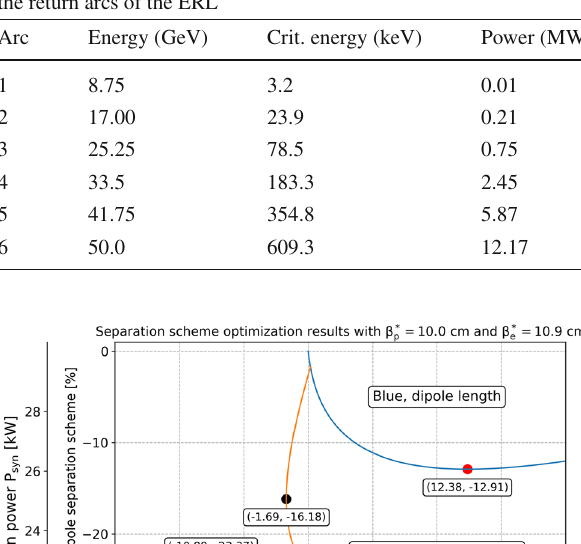
Table 4 Luminosity and transverse emittance growth for the optical matching Parameters Optical